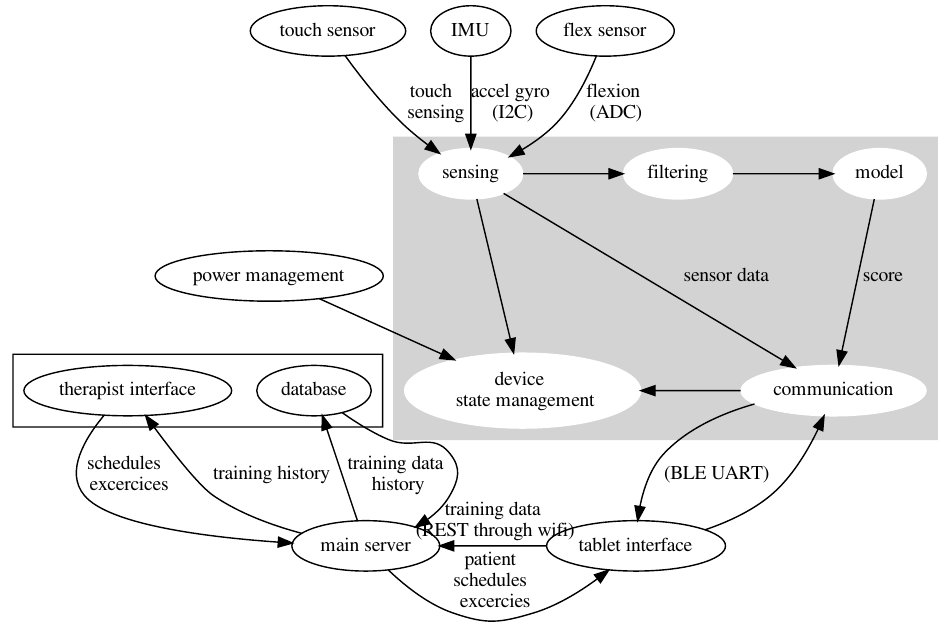
Figure 3. Diagram showing the elements of the Przypominajka v2 system, their role, and communi- cation